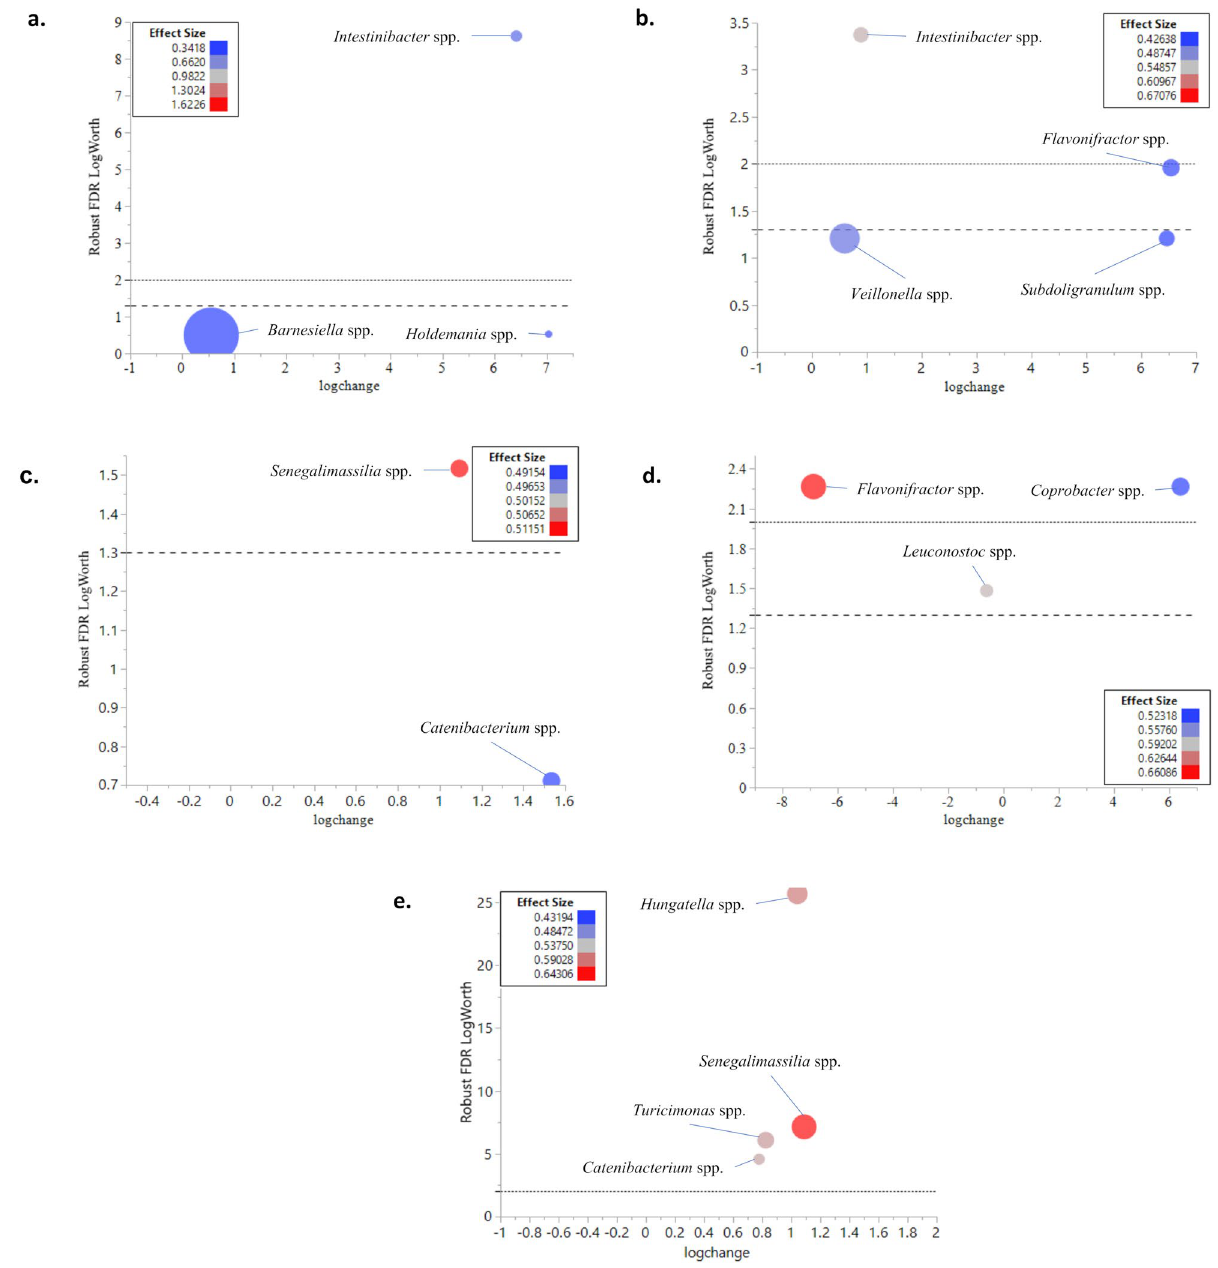
Figure 4. Comparison of the microbiota profiles of ( a ) TA_rich versus RawExtract, ( b ) TA_rich versus TA_poor, ( c ) TA_rich versus Control, ( d) TA_poor versus RawExtract, ( d) RawExtract versus Control feeding groups (line at 1.3 (- - -) = p value 0.05, line at 2 (----) = p value 0.01 adjusted for FDR) The log fold change in genera relative abundances in samples is plotted versus the corrected robust false discovery rate (FDR) LogWorth (i.e., log10P). The size of the circles represents the mean relative abundance of each genus, and colour represents the effect